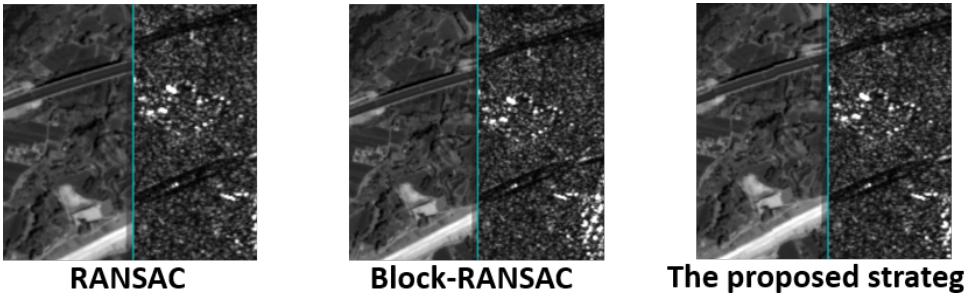
Figure 18. Details of image transformation relationships detected by RANSAC, Block-RANSAC and the proposed strategy in pair C.